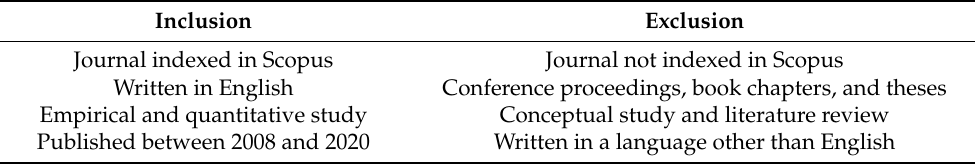
Table 2. Inclusion and exclusion criteria for the systematic